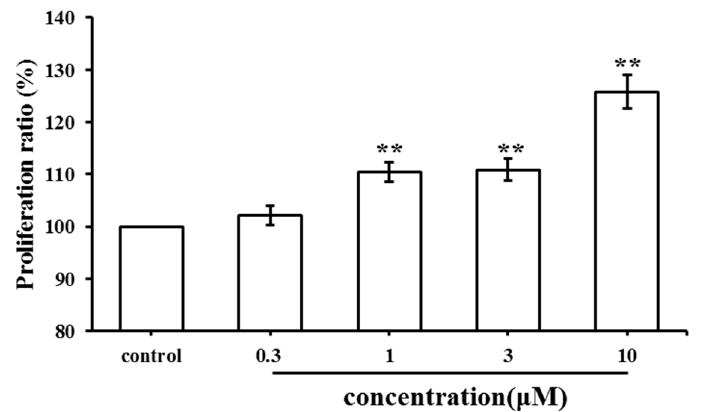
Figure 2. Effect of SC treatment on the MC3T3-E1 cell proliferation (** p < 0.01 compared with the control group.